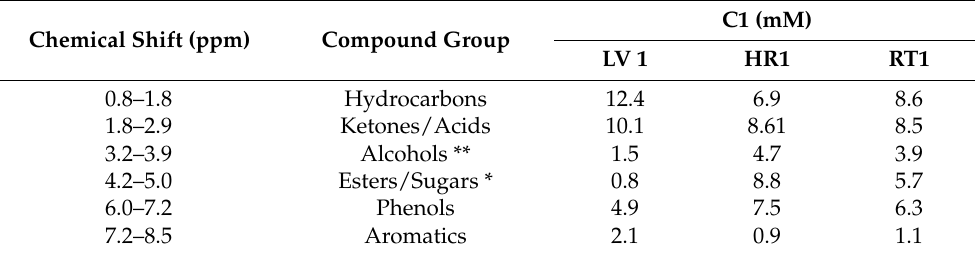
Table 2. Concentration of compound groups in hemp distillates of leaves, hurds, and roots at a condensation temperature of 130 ◦ C by 1 H NMR.